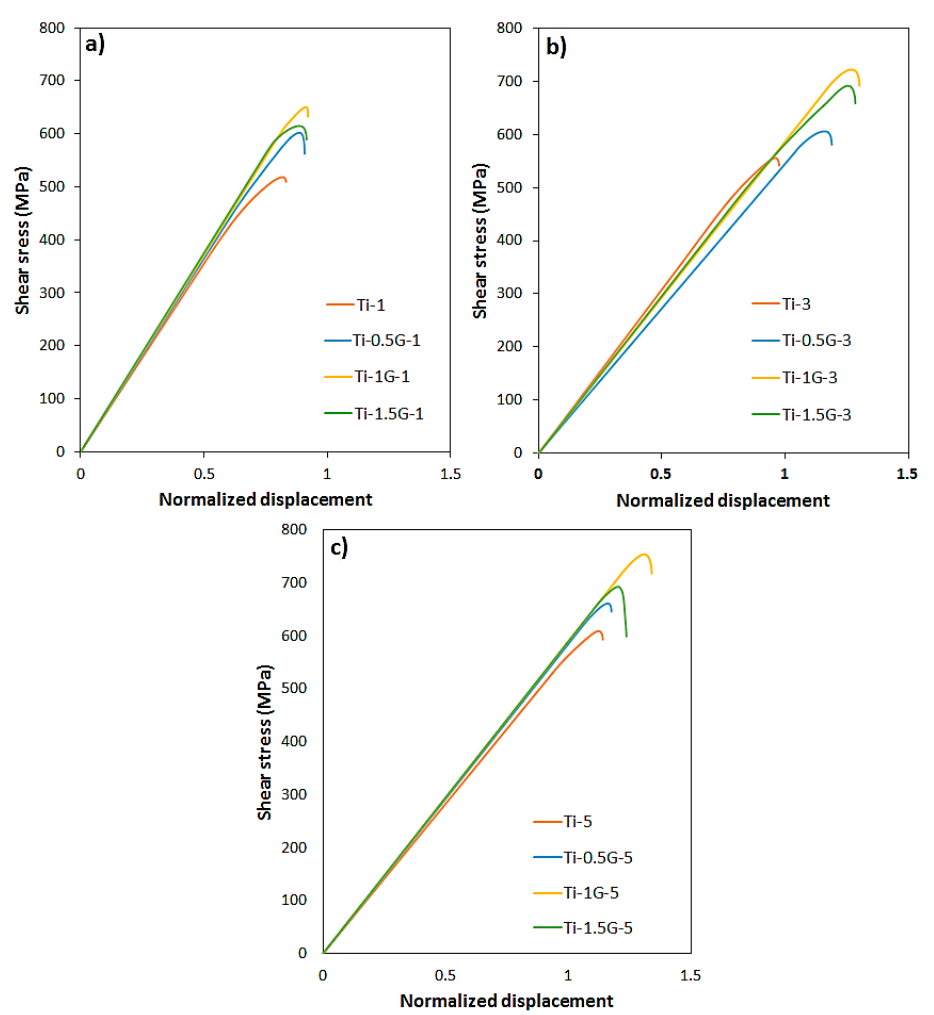
Figure 8. Shear stress versus normalized displacement curves of composites sintered at various time periods, ( a ) sintered for 1 h, ( b ) sintered for 3 h, and ( c ) sintered for 5 h.